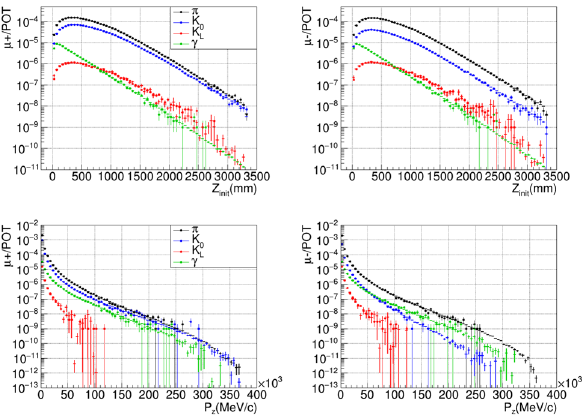
Fig. 3 SameasinFig.2,butwithcontributionssplitbymotherparticle